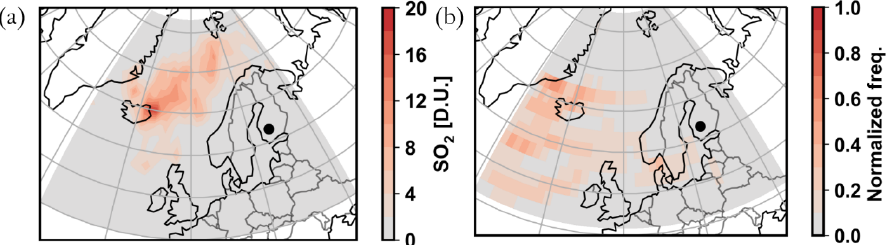
Figure A6. (a) Average SO 2 concentration in the atmospheric column derived from the ozone monitoring instrument (OMI) aboard Aura satellite for September 2014. High values near Iceland are due to the 2014–2015 flood lava eruption of the Bárðarbunga volcano. (b) A 2-D normalized histogram of air parcel back trajectories arriving at the SMEAR II station for September 2014. The trajectories are computed using the HYSPLIT model going back 96h in time with a resolution of nine arriving trajectories per hour. Each air parcel path is recorded for each hour. These points are binned in 2 × 2 ◦ cells. The counting of each cell is then normalized by multiplying it with the square of the distance to the SMEAR II station (black disk marker) in order to highlight the long-range transport